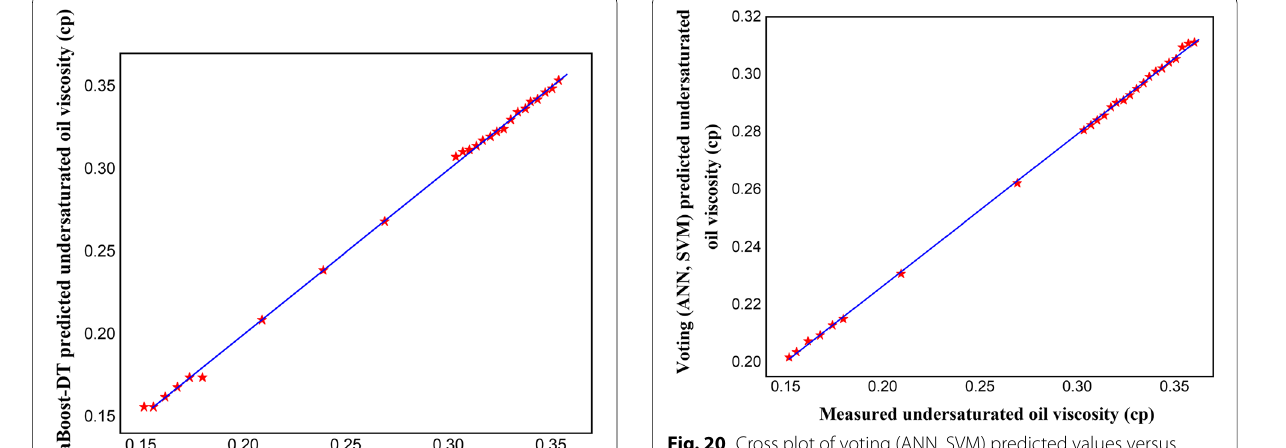
Fig. 20 Cross plot of voting (ANN, SVM) predicted values versus measured values